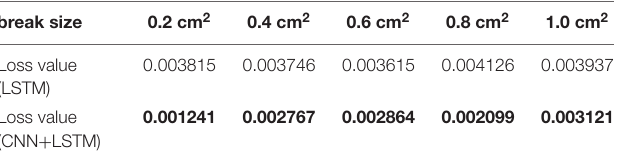
TABLE 4 | Comparison of prediction